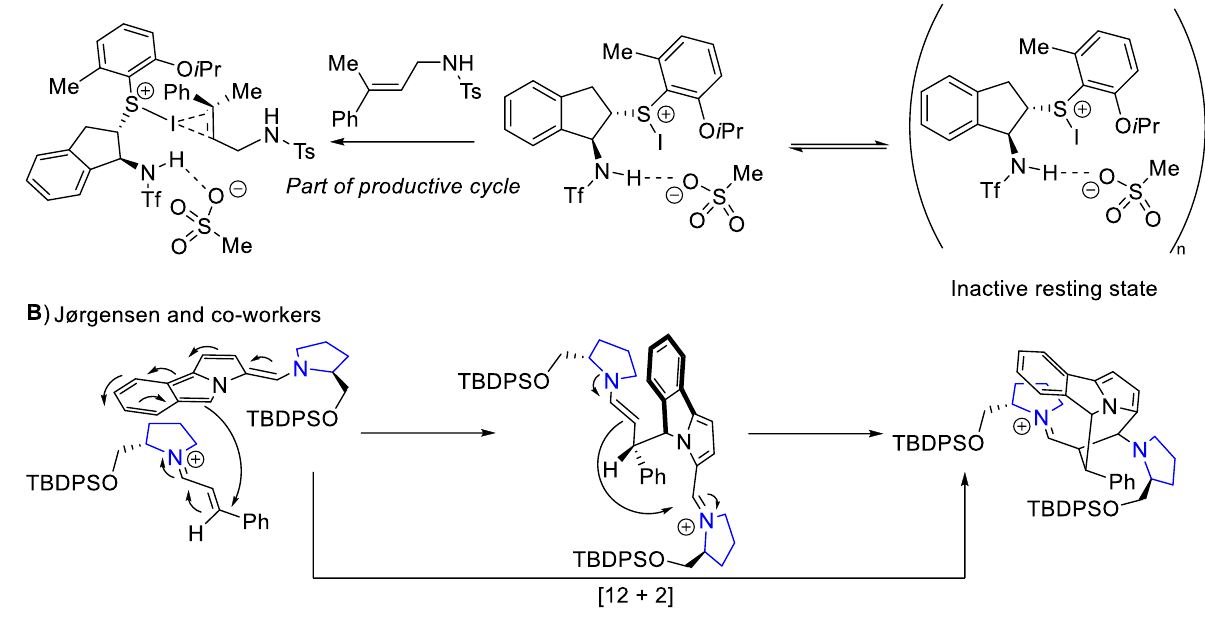
Figure 11. Examples of recent work with proposed NLE. ( A ) Difunctionalization of allylic sulfona- mides via iodination as reported by Zhao and co-workers [124]. ( B ) Proline derivative-catalyzed amides via iodination as reported by Zhao and co-workers [123]. ( B ) Proline derivative-catalyzed [12+2] cycloaddition as reported by Jørgensen and co-workers [126]. [12+2] cycloaddition as reported by Jørgensen and co-workers